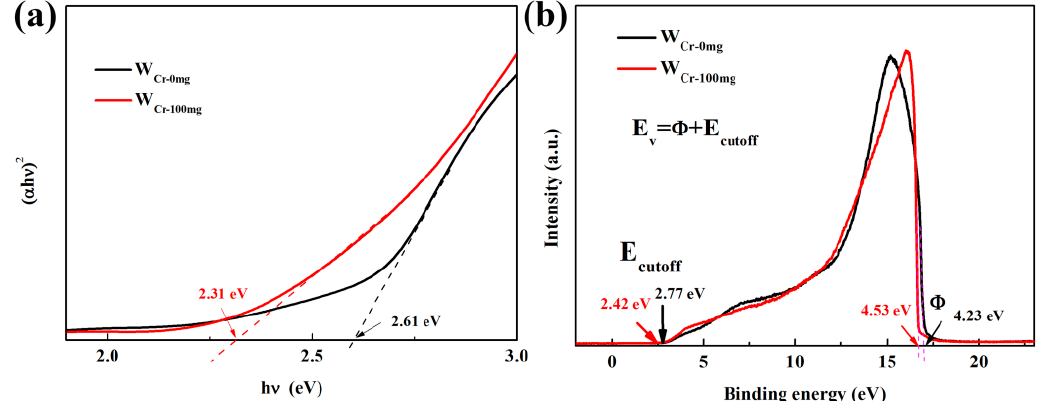
Figure 13. ( a ) ( α h ν ) 2 -h ν curves of pure and Cr-doped WO 3 , and ( b ) the valence band of pure and Cr- doped WO 3 measured by ultraviolet photoelectron spectroscopy (UPS) (He I excitation, h ν = 21.22eV) spectra.